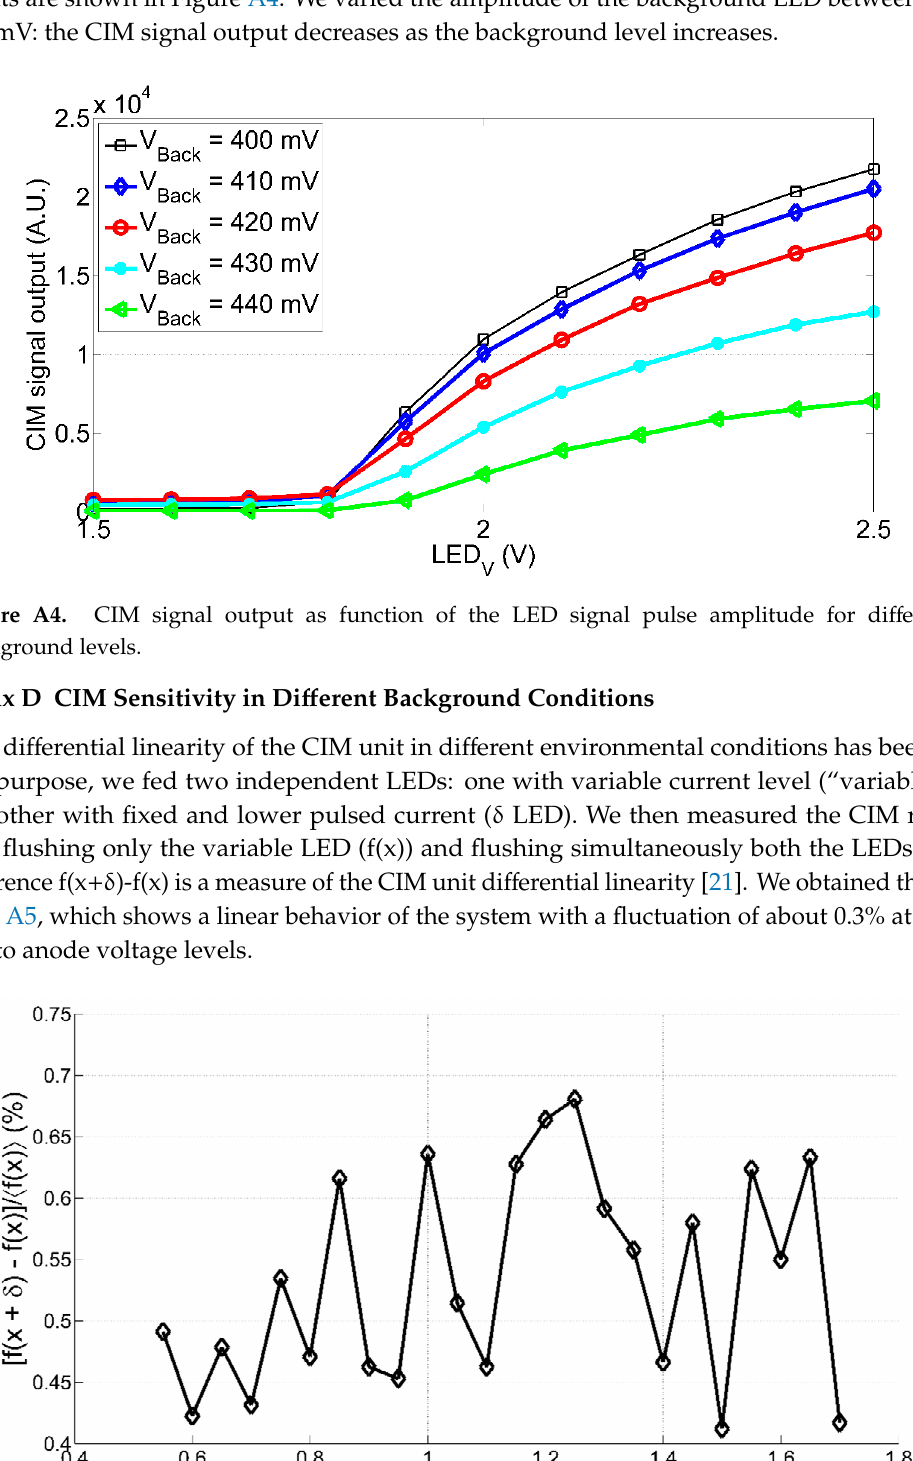
Figure A3. LCTF transfer function test. From the left: the theoretical fluorescence water spectrum; the convolution between the theoretical spectrum and the LCTF transfer function, as shown in Figure 2 of the main text.